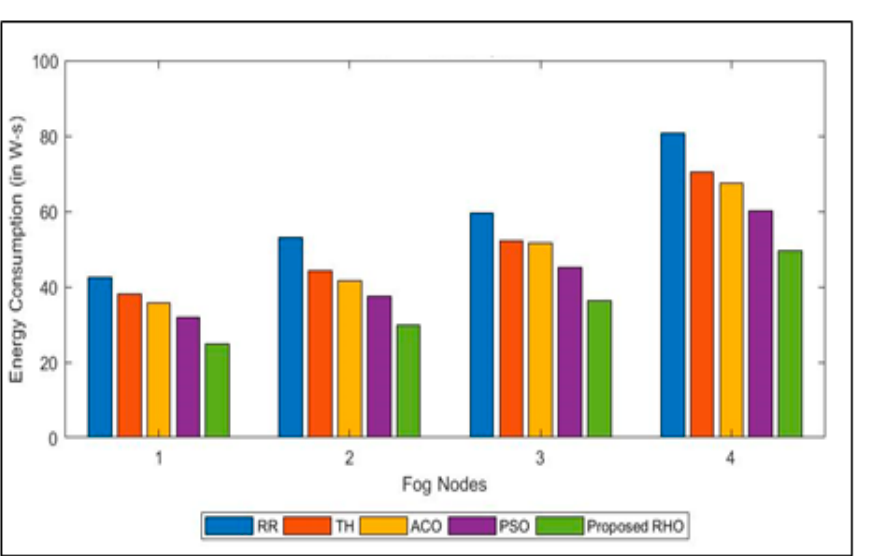
Figure 9. Energy Consumption for different algorithms for different Fog Nodes .